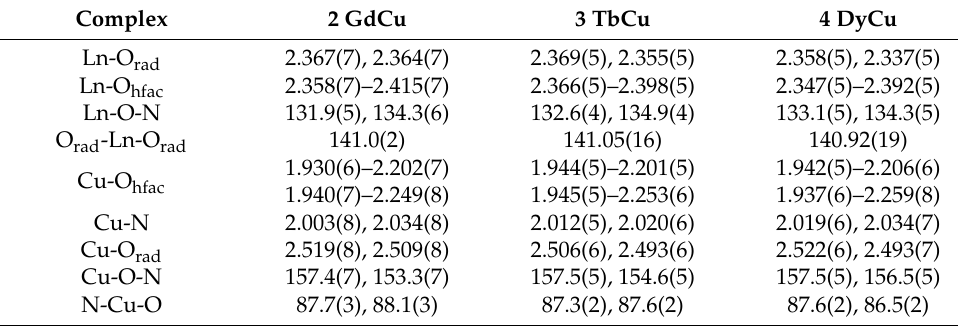
Table 4. Key bond lengths [Å] and angles [ ◦ ] for complexes 2 – 4